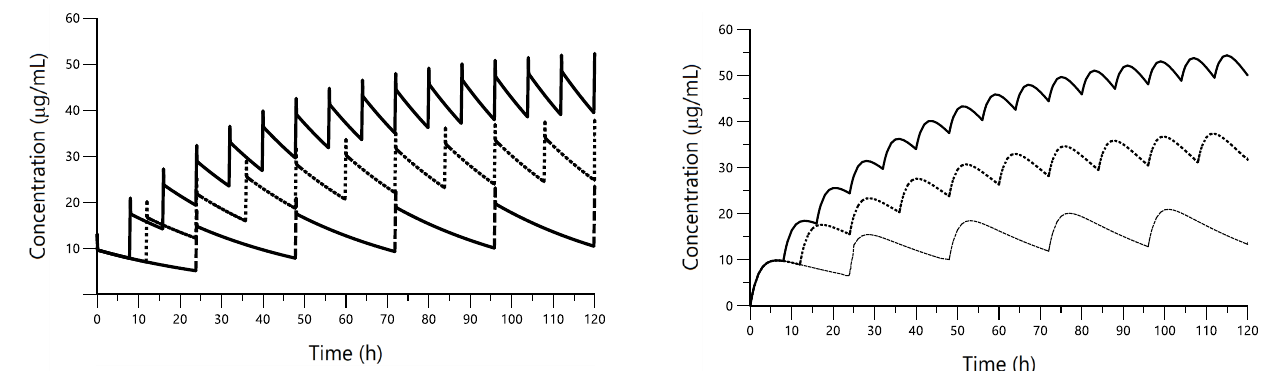
Figure 4. Plots of overlayed simulated concentrations achieved after IV ( left ) and IM ( right ) administration of CP at 3 and 4 mg/kg, respectively, every 8 (solid line), 12 (dotted line) and 24 h (dashed line).